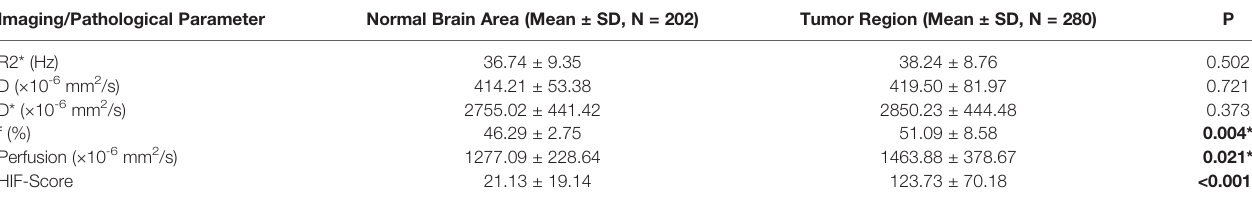
TABLE 1 | Mean parameter values for tumor and normal brain tissues. Imaging/Pathological